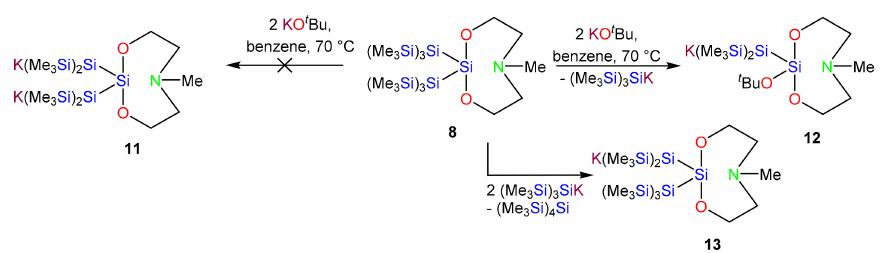
Scheme 5. Attempted formation of silocanyloligosilane diide 11 , by reaction of 8 with two equiv KO t Bu. Instead, tert- butoxysilocanyloligosilanide 12 was obtained. Reaction of 8 with